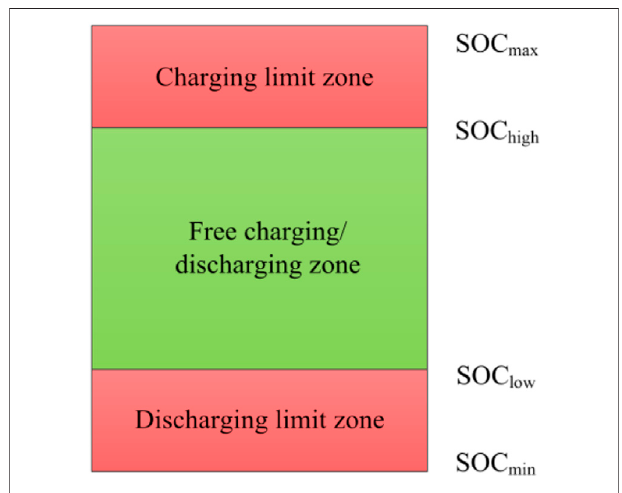
FIGURE 7 | SOC restriction classi fi cation of energy storage